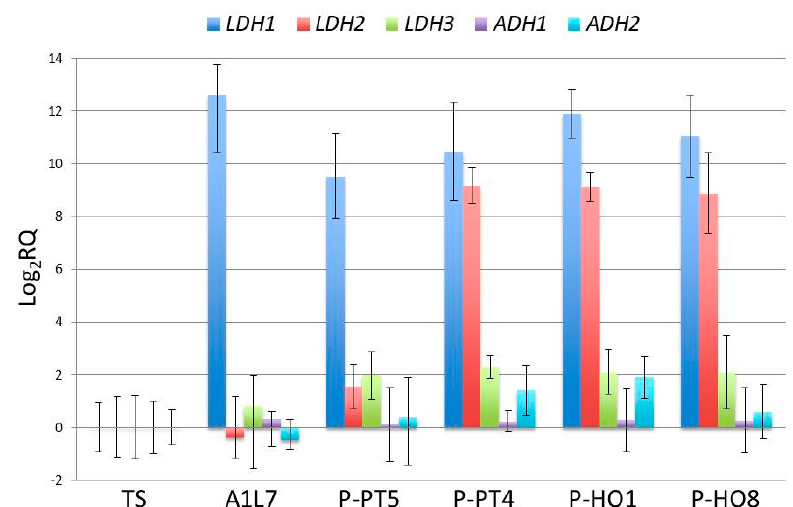
Figure 5. Quantitative PCR (qPCR) analysis of the L. thermotolerans lactate dehydrogenase ( LDH ) and alcohol dehydrogenase ( ADH ) genes in high- (P-PT4, P-HO1, P-HO8) and low- (A1L7, P-PT5) lactic acid-producing strains. The low lactic acid-producing L. thermotolerans type strain (TS) was used as reference (Log 2 RQ = 0). RQ—relative quantification. Error bars—log 2 RQmin and log 2 RQmax; RQmin